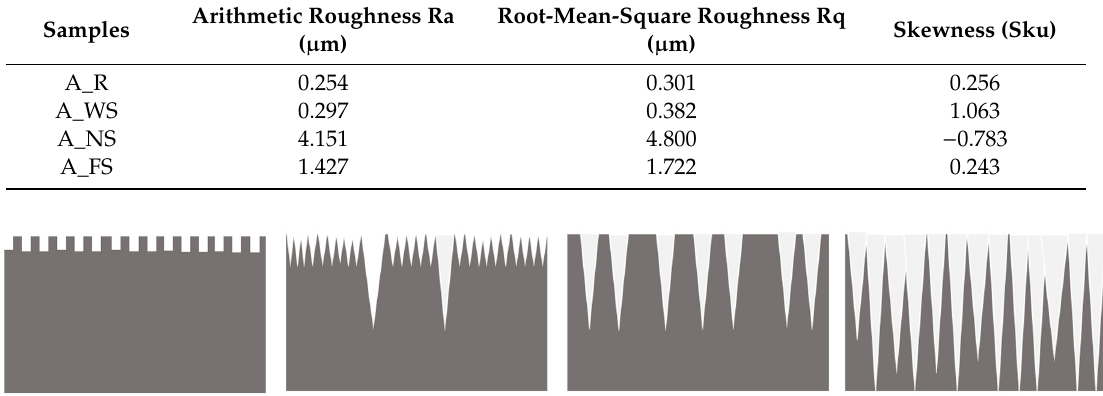
Table 2. Roughness parameters of di ff erent prepared samples.